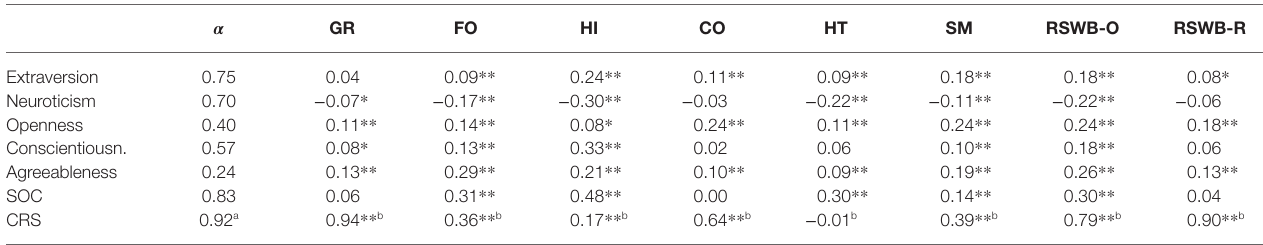
TABLE 5 | MI-RSWB-S in relation to personality traits, Sense of Coherence, and religiosity. α GR Extraversion